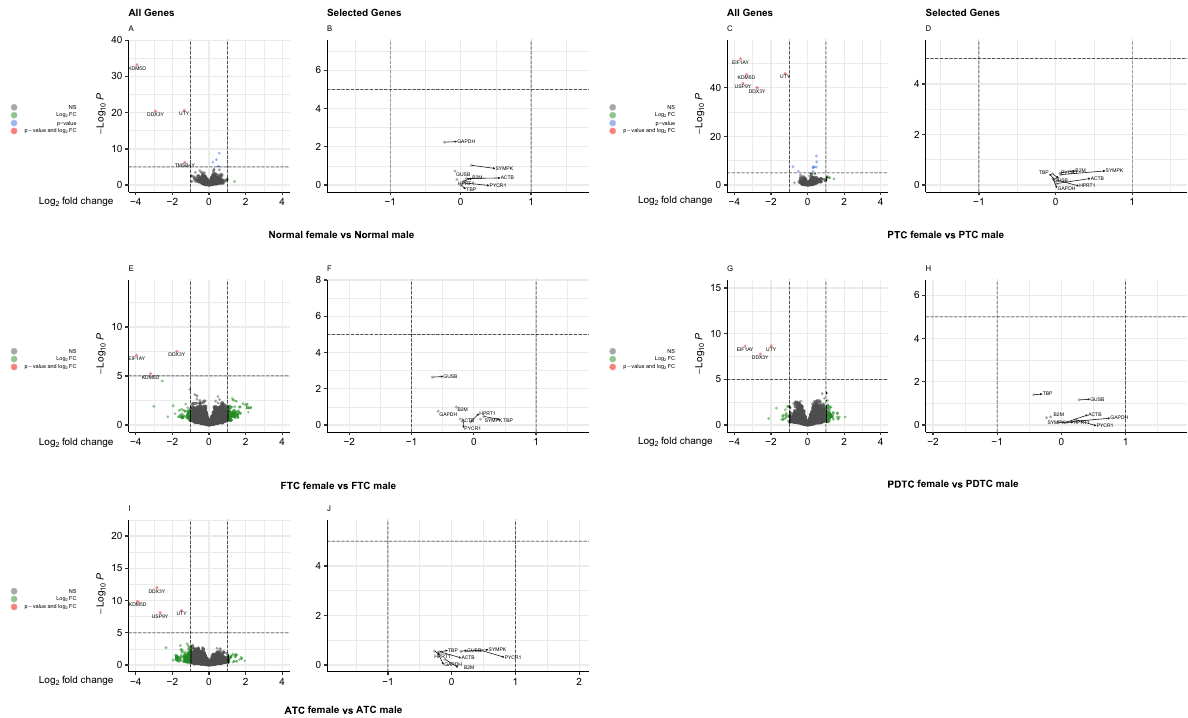
Figure 6. Volcano plots of differentially expressed genes and selected reference genes in a microarray meta- data based on intra-subtype and inter-sex analysis. ( A ) all genes and ( B ) selected reference genes of normal female versus normal male analysis. ( C ) all genes and ( D ) selected reference genes of PTC female versus PTC male analysis. ( E ) all genes and ( F ) selected reference genes of FTC female versus FTC male analysis. ( G ) all genes and ( H ) selected reference genes of PDTC female versus PDTC male analysis. ( I ) all genes and ( J ) selected reference genes of ATC female versus ATC male analysis.